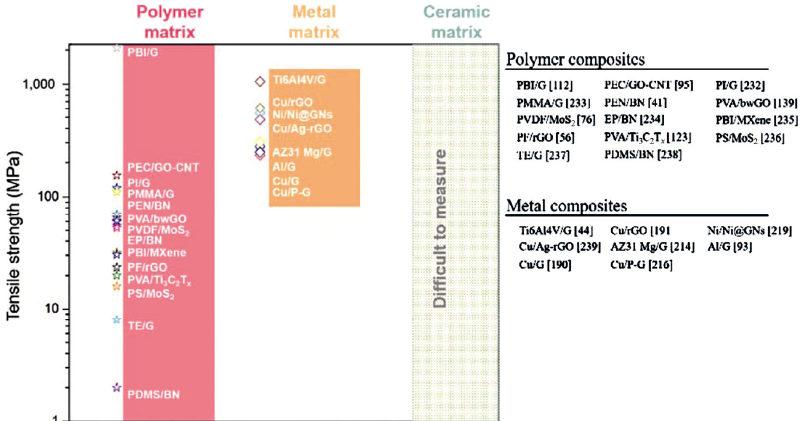
Fig. 14 Comparison of various matrices incorporating 2D materials (PBI: polybenzimidazole; PS: polystyrene; TE: thermoplastic elastomers; PDMS: polydimethylsiloxane; bwGO: base-washed graphene oxide; P-G: plasma treated graphene).